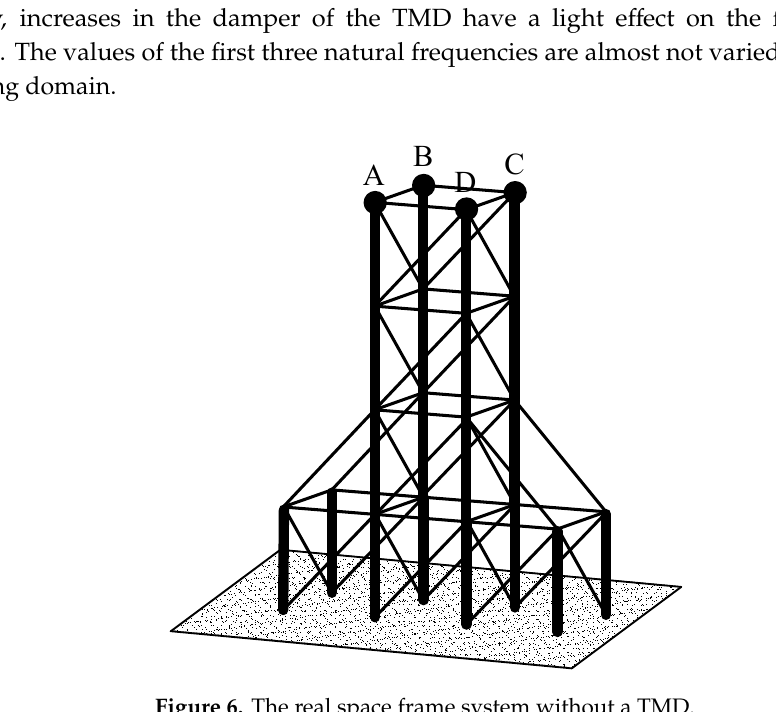
Figure 6. The real space frame system without a TMD. Table 7. The comparison of the first three natural frequencies of the space frame.